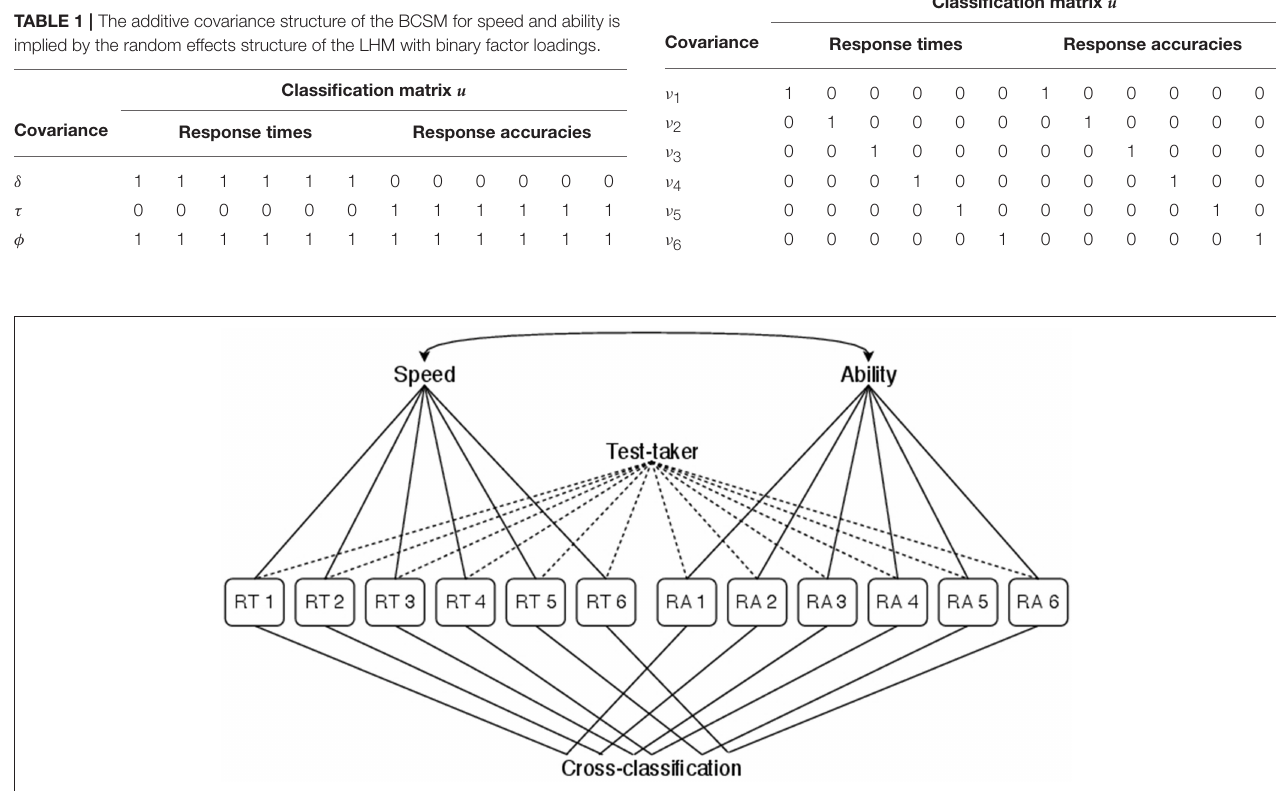
Frontiers in Psychology |